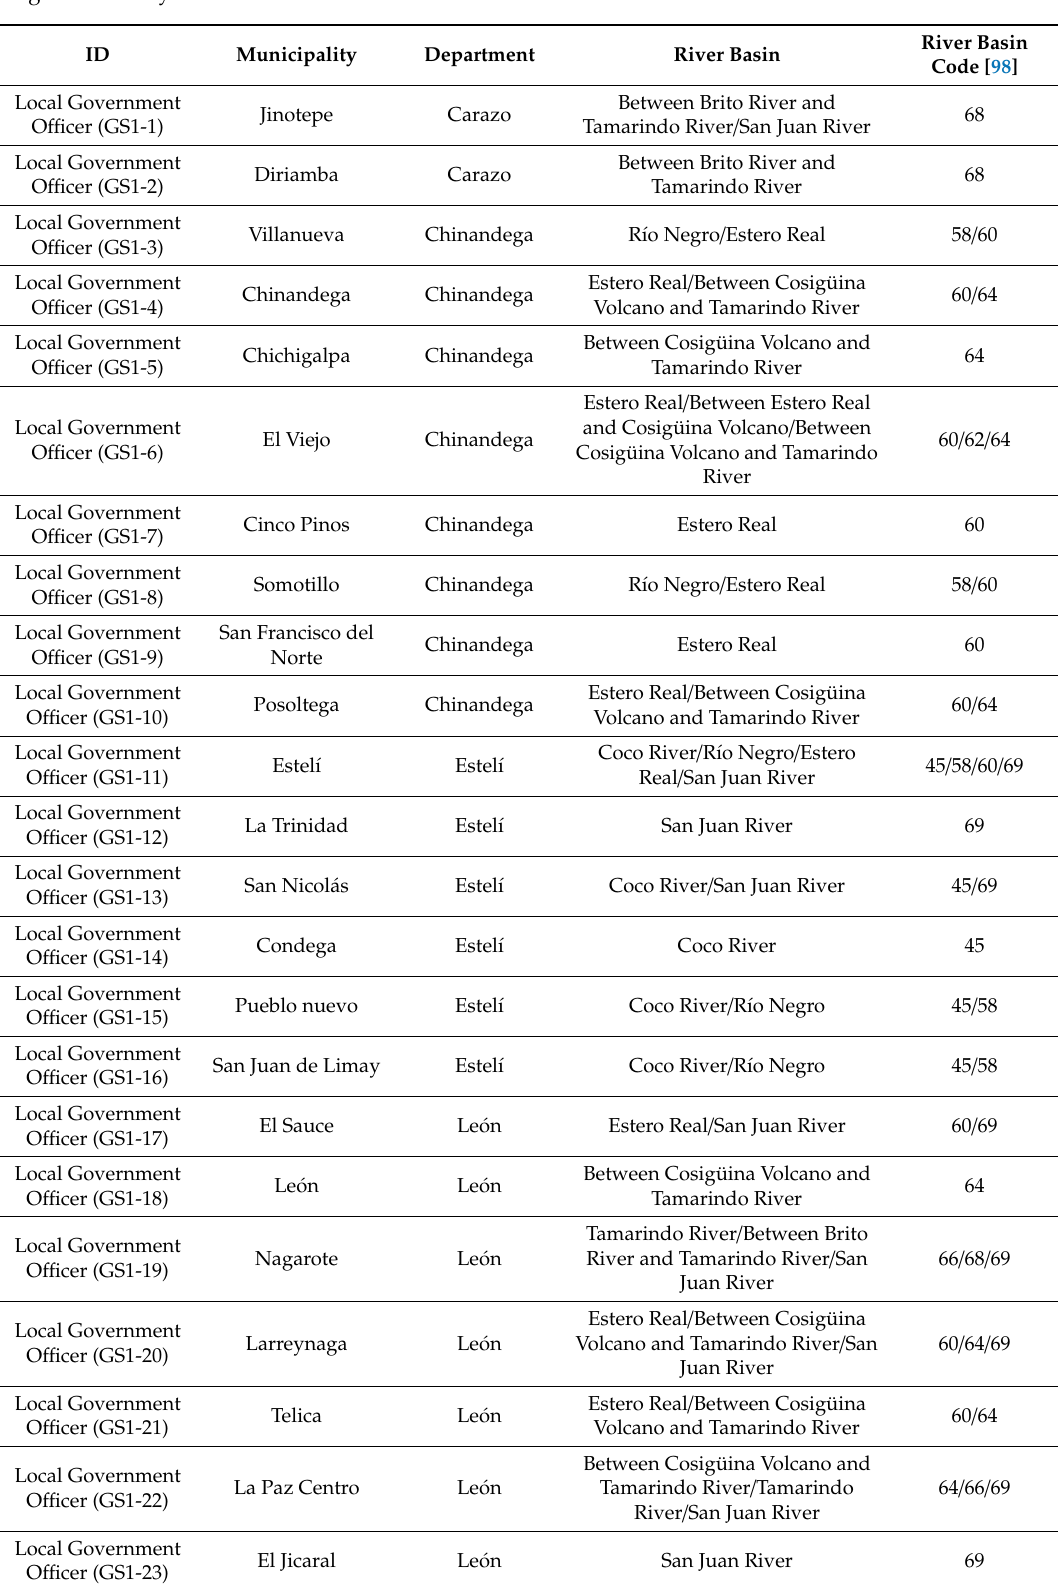
Table A2. Geographic and hydrographic distribution of stakeholders interviewed in the governance